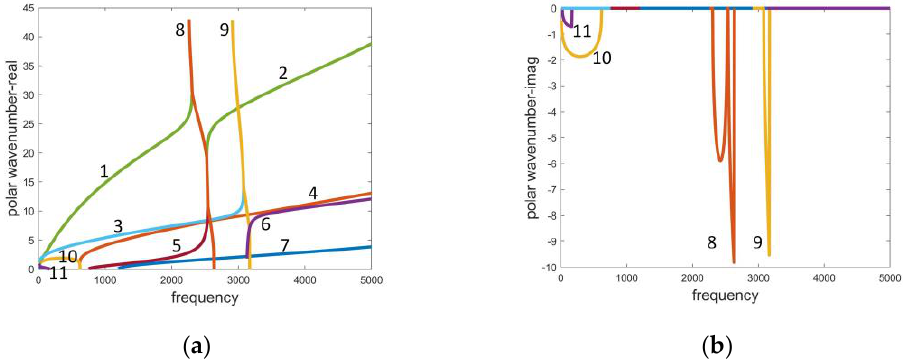
Figure 4. Dispersion curves of the stator cell ( a ) real part ( b ) imaginary part.